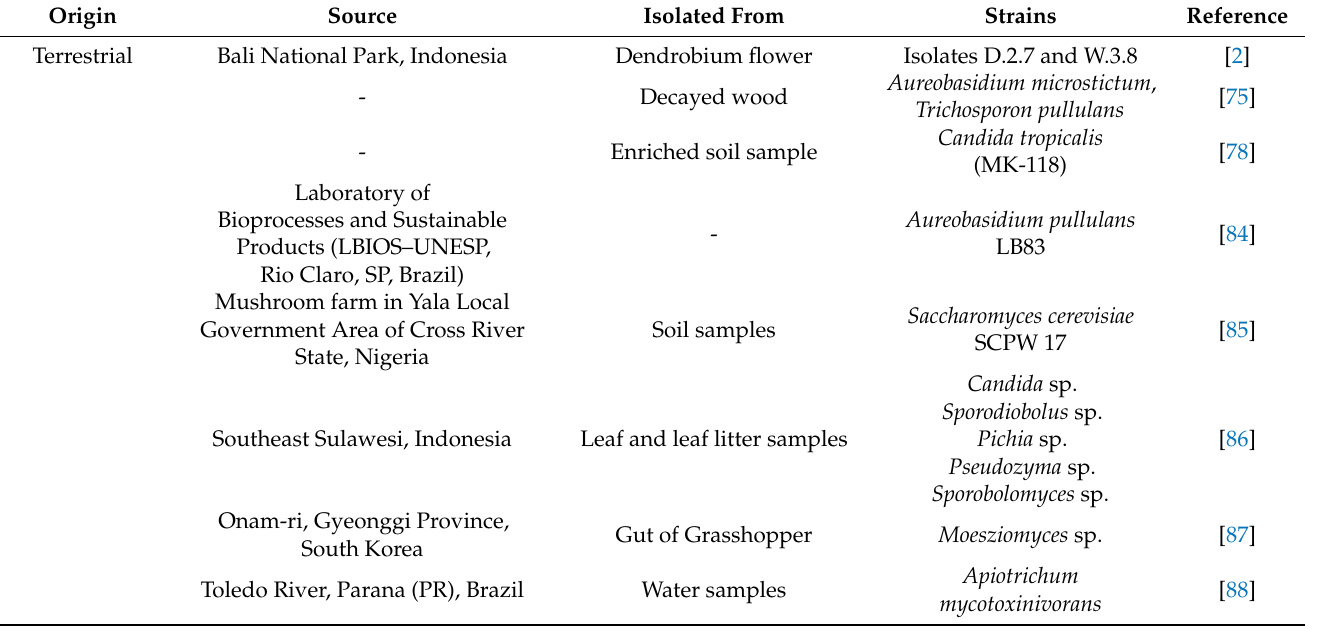
Table 2. Examples of few reported cellulolytic